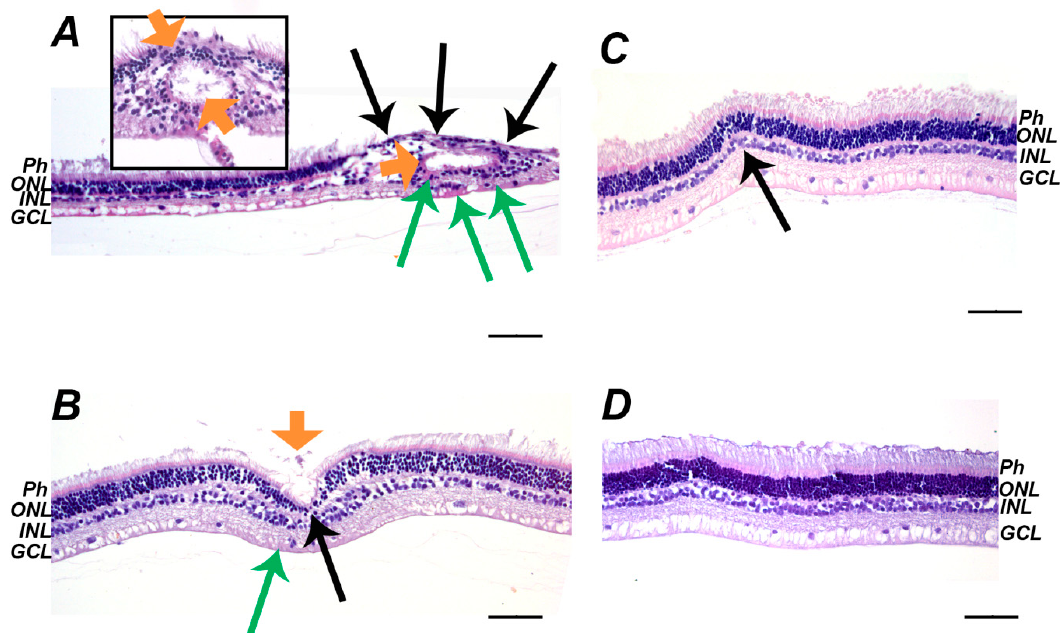
Figure 6. Histopathological findings in rabbit retina seven days after the illumination with intense visible light (30,000 lx, 3 h) without treatment ( A ), after premedication with SkQ1 ( B ), after treatment with Nepafenac ( C ), and after premedication/treatment using the combination of the both drugs ( D ). ( A ): The retina demonstrates severe signs of damage including thinning of ONL and INL and total loss of photoreceptors (black arrows), gliosis, glial scar formation and formation of canals filled with edematous fluid (orange arrows) as well as Muller glia activation and hypertrophy (eosinophilic areas, green arrows). ( B ): The retina exhibits much less prominent damage (thinning of ONL and INL–black arrow, glial activation–green arrow), but signs of pre-existent inflammation are present (debris in semi-canal, orange arrow). ( C ): The retina shows thinning of ONL (black arrow) without signs of inflammation. ( D ): No signs of the retinal damage and/or inflammation. Representative cross-sections of retina, staining with hematoxylin and eosin; magnification 200× (400× on inset). Scale bar 20 μ m. Abbreviations: GCL, ganglion cell layer; INL, inner nuclear retinal layer; ONL, outer nuclear retinal layer; Ph, photoreceptor layer.